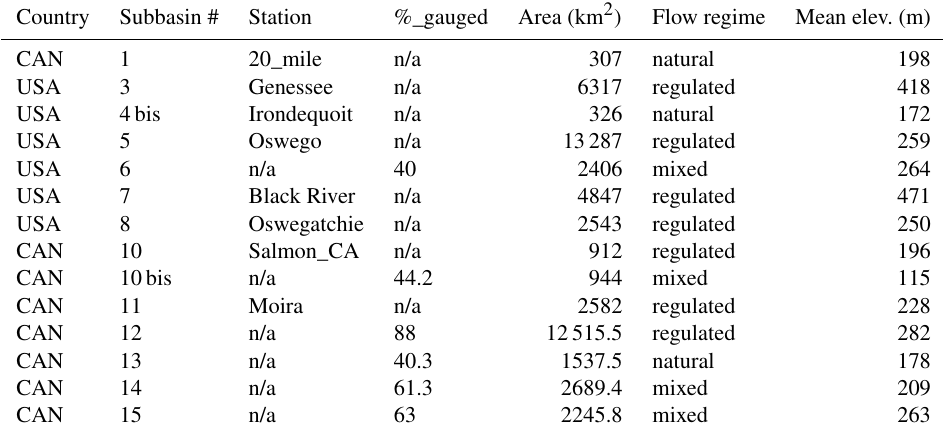
Figure 5. Uncalibrated and calibrated GEM-Hydro-UH performances over the calibration period. Results are presented as NSE PBIAS (b) , for many GRIP-O subbasins. The gray dashed line shows perfect scores and GR4J reference is displayed with black markers. Table 3. GRIP-O subbasin characteristics. n/a: not